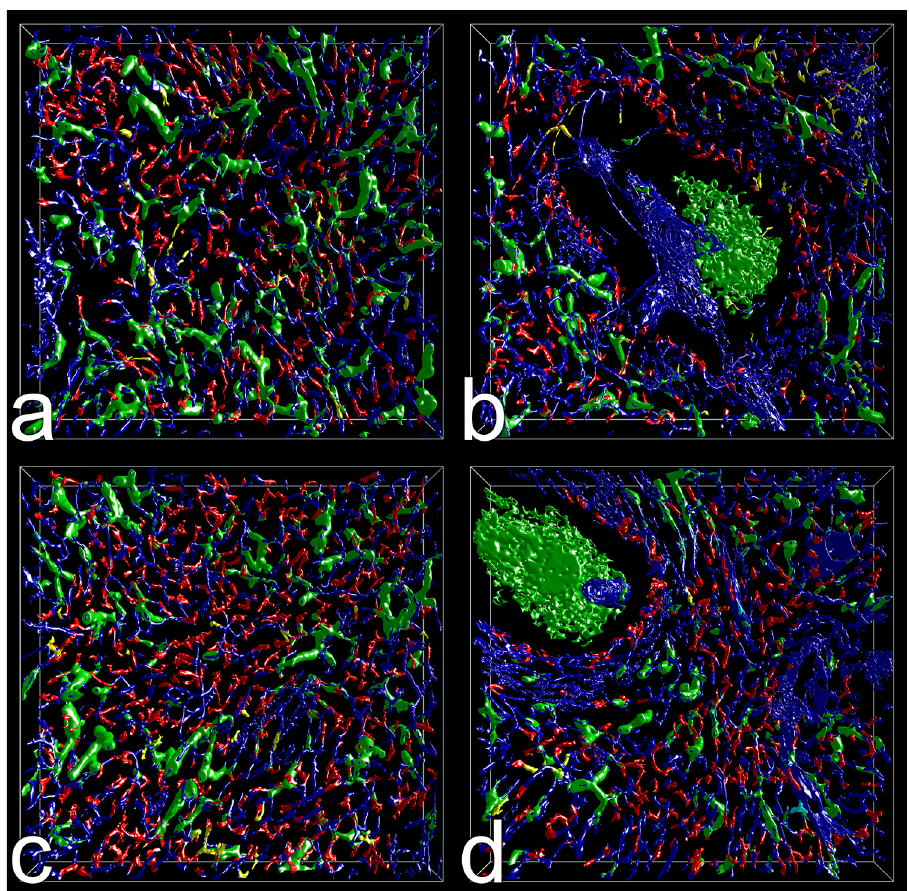
Figure 4. Models of ROI 1–4 ( a – d ) with open capillary ends unconnected to sinuses manually highlighted in red. The ends were individually inspected for typical capillary end processes by fusing the model with the sequence of registered sections as shown in Fig. 5a–d and Supplementary videos S3, S4. Artificial interruptions of capillaries and ambiguous findings are marked in yellow. Three non-interpretable capillary structures at the surface of red pulp venules were colored cyan in ( d ). Arterioles within the follicle in ( b ) and ( d ) are interrupted due to tears caused by sectioning. Side of bounding boxes = 1